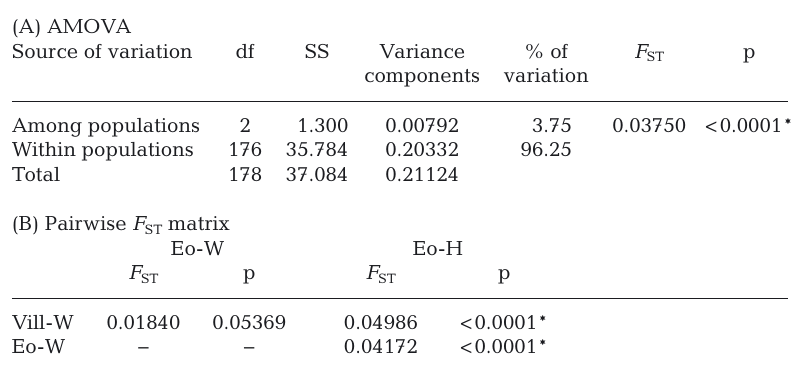
Table 3. (A) Analysis of molecular variance (AMOVA) and (B) pairwise F ST values for Ruditapes decussatus from Ría de Villaviciosa (Vill) and Ría del Eo (Eo) estuaries in Asturias, northern Spain. W: wild, H: hatchery. *Significant at p <